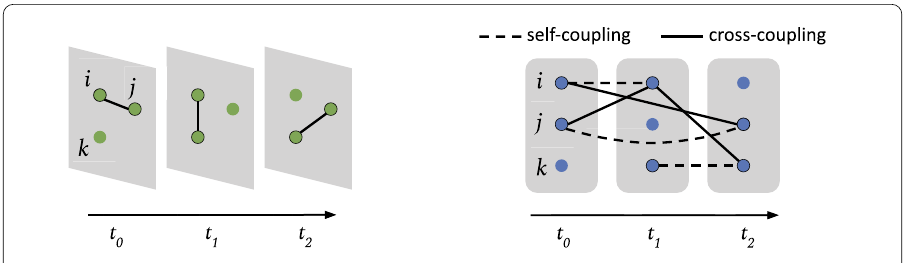
Figure 1 A time-varying graph H with three intervals (left) and its corresponding time-respecting supra-adjacency graph G H